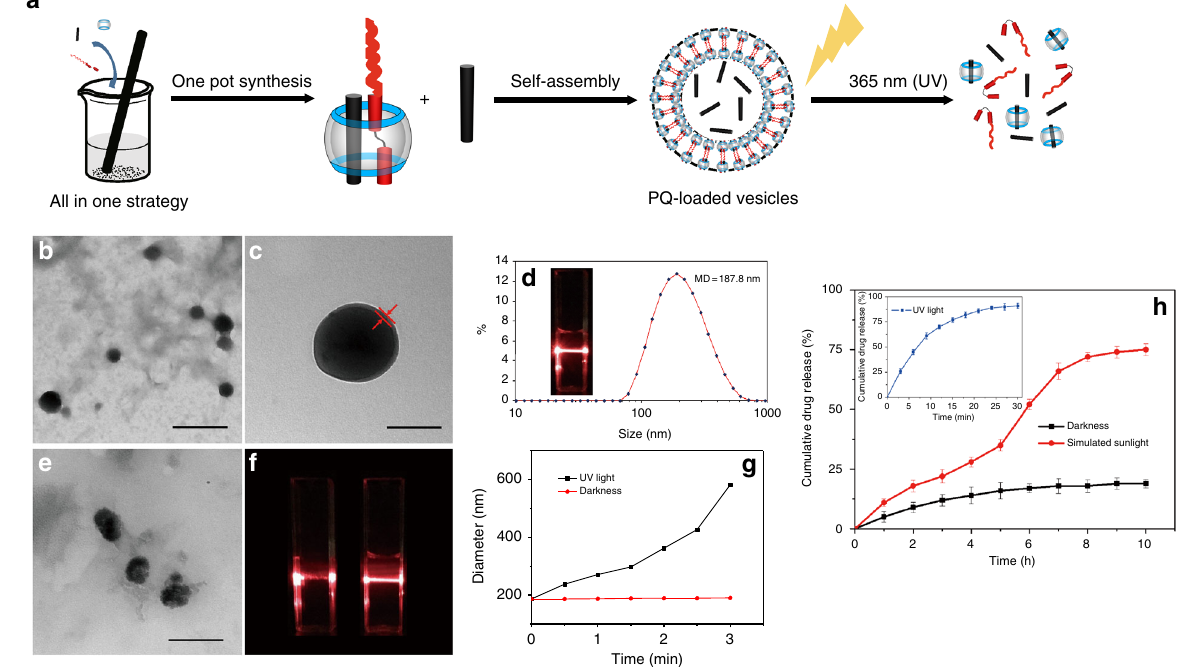
Fig. 2 Preparation of photo-responsive vesicles. a Schematic illustration of the preparation and photo-responsiveness of PQ-loaded vesicles. b TEM image of vesicles. Scale bar: 500 nm. c Enlarged TEM image. Scale bar: 100 nm. d DLS data of vesicles. Inset: photo showing the Tyndall effect of vesicles; e TEM image of vesicles after exposure to UV light. Scale bar: 500 nm. f Tyndall effect of vesicles before (left) and after (right) exposure to UV light. g Diameter changes of vesicles over time in the dark or under irradiation by UV light. h Release pro fi le of PQ from PQ-loaded vesicles in the dark and under irradiation by simulated sunlight. Inset: release pro fi le of PQ from PQ-loaded vesicles under irradiation by UV light. Data was combined from three individual experiments and presented as means ±